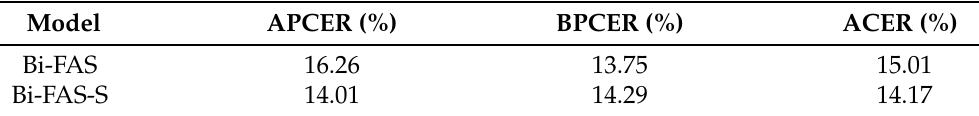
Figure A1. A few frames extracted from the videos of our self-acquired dataset. Table A1. Performance of our proposed architecture on our self-acquired dataset and trained on Protocol I of the OULU-NPU